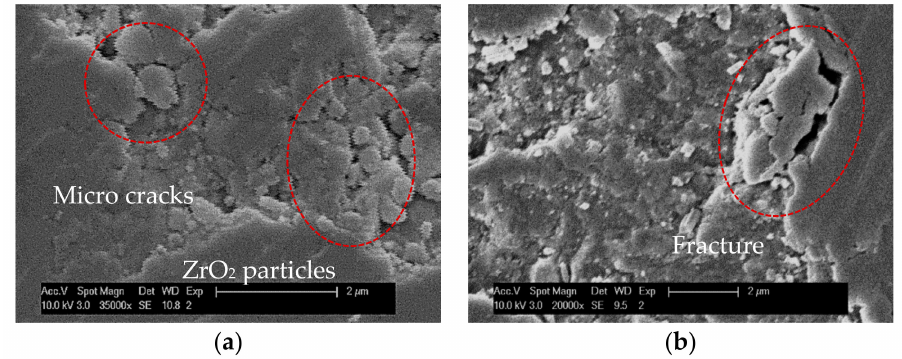
Figure 16. Machined surface flaws: ( a ) crushed in to particles; ( b ) fractured from